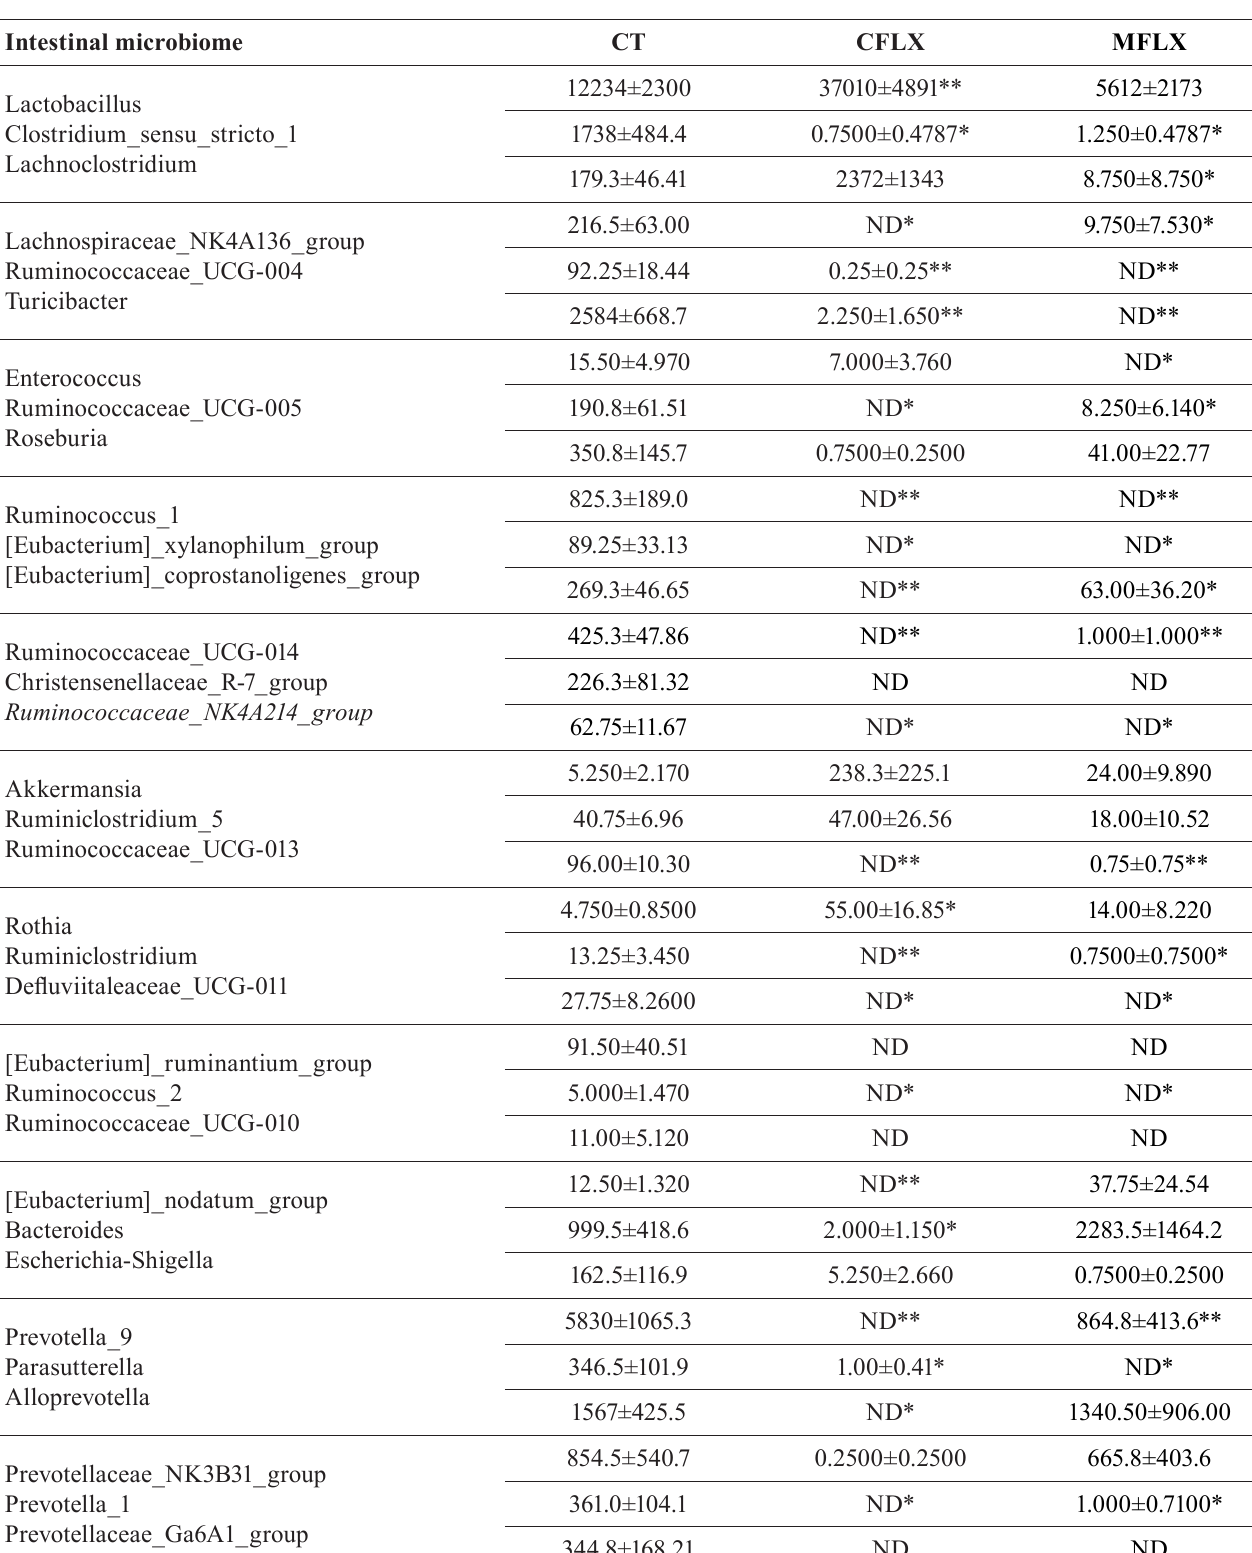
Supplementary Table SIV - The genus abundance of intestinal